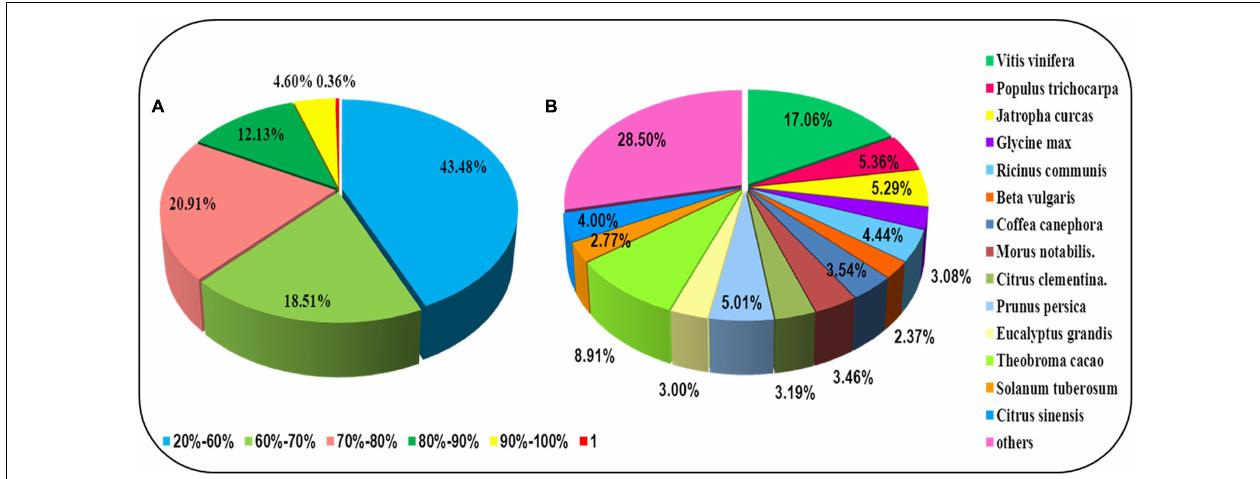
FIGURE 3 | Results summary for sequence-homology searching against the UniProt database. (A) Similarity distribution of the closest BLASTX matches for each sequence. (B) A species-based distribution of BLASTX matches for sequences. We used all plant proteins in the UniProt database in performing the homology search.